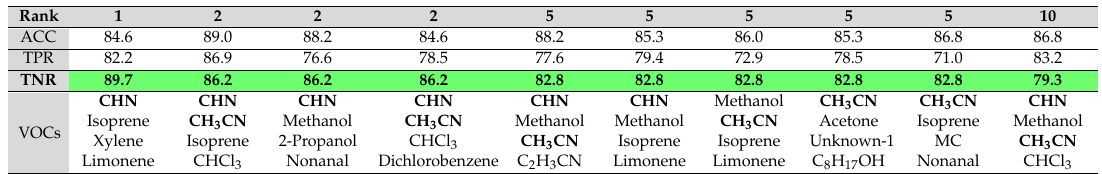
Table 4. Top 10 VOC combinations sorted by TNR (%) (4 VOCs were trained, MC = methylcyclohexane; boldface: most frequent